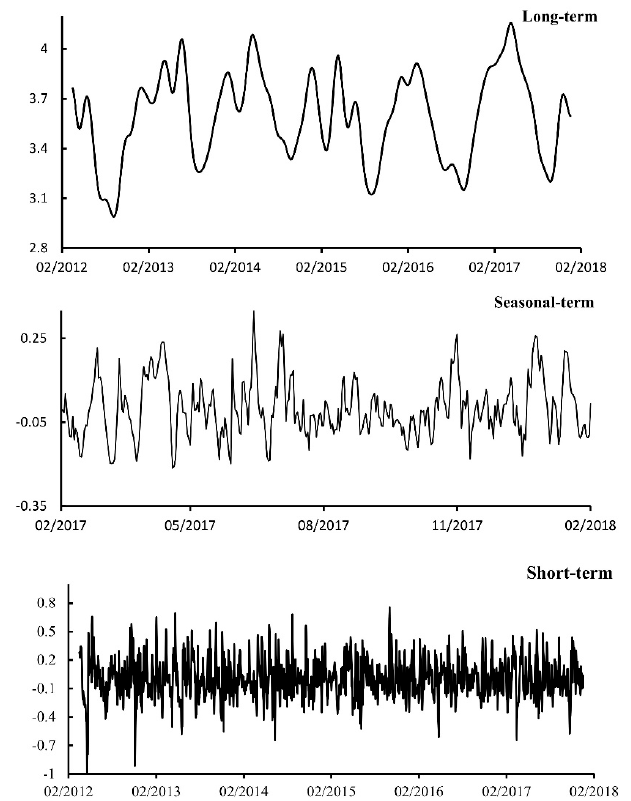
Figure 5. Time series decomposition of the water discharge (N = 2101) separated into the long, seasonal, and short-term component. The water discharge is the logarithmic transformation of the cubic meters per second values measured from 1 February 2012 to 1 February 2018.